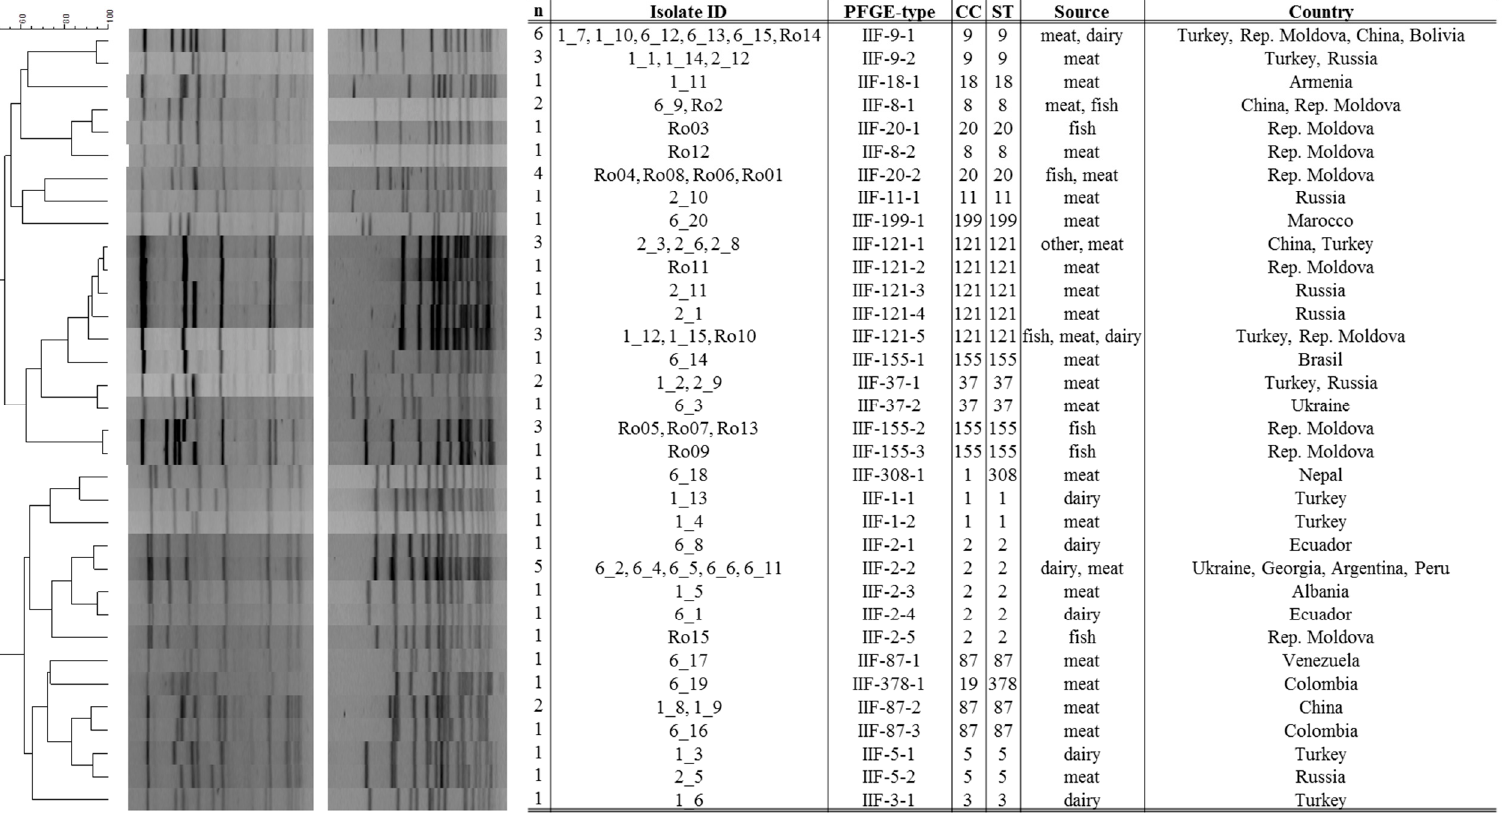
Figure 2. Combined pulsed-field gel electrophoresis (PFGE) cluster analysis of 57 L. monocytogenes isolates. Combined PFGE cluster analysis of L. monocytogenes isolates from this study (restriction enzymes Asc I & Apa I). The TIFF images were compared using BioNumerics 6.6 software (Applied Math NV, Sint-Martens-Latem, Belgium), and normalized using the PFGE global standard Salmonella ser. Braenderup H9812. Pattern clustering was performed using the unweighted pair group method using arithmetic averages (UPGMA) and the Dice correlation coefficient was applied with a position tolerance of 1.5%.